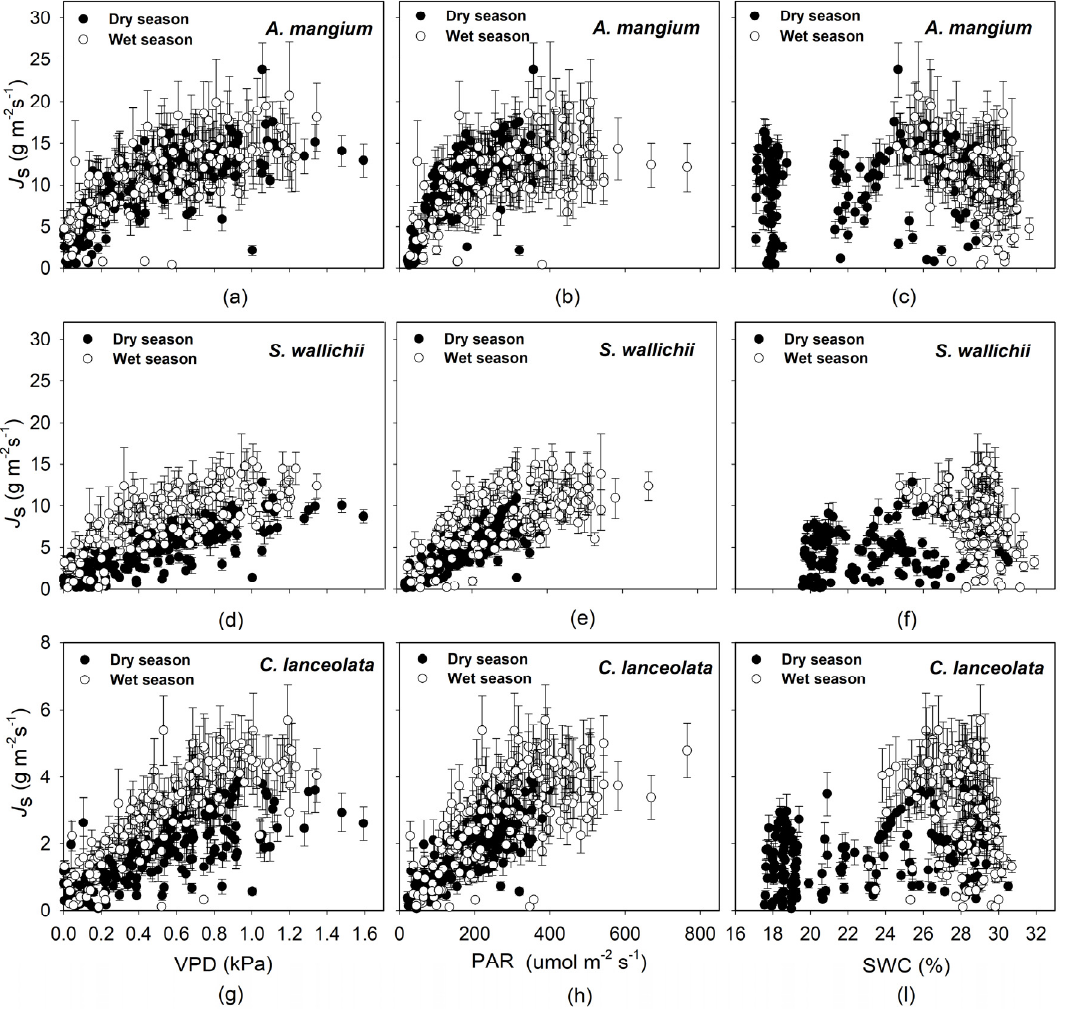
Figure 4. Raw data of daily (including daytime and nighttime) sap flux density ( J s ± standard error) to average vapor pressure deficit (VPD) at ( a ) A. mangium site, ( d ) S. wallichii site, ( g ) C. lanceolata site; photosynthetically active radiation (PAR) at ( b ) A. mangium site, ( e ) S. wallichii site, ( h ) C. lanceolata site; and soil water content (SWC) at ( c ) A. mangium site; ( f ) S. wallichii site; ( l ) C. lanceolata site in the dry and wet seasons. (note that the y-axis of C. lanceolata has a different scale compared with that of the other two species).